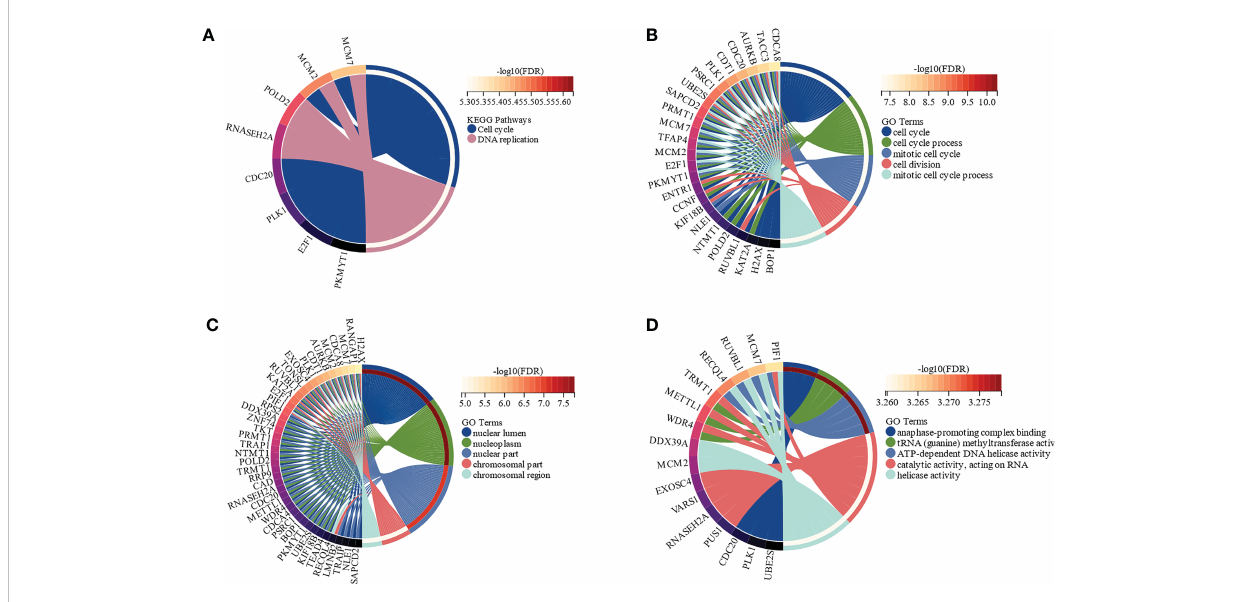
FIGURE 4 Functional enrichment analysis of the hub genes by Kyoto Encyclopedia of Genes and Genomes (KEGG) and Gene Ontology (GO) (FDR < 0.01). (A) The functions of the hub genes in KEGG pathways. (B) Top 5 pathways of the hub genes involved in GO biological process (BP) terms. (C) Top 5 pathways of the hub genes involved in GO cellular component (CC) terms. (D) Top 5 pathways of the hub genes involved in GO molecular function (MF)